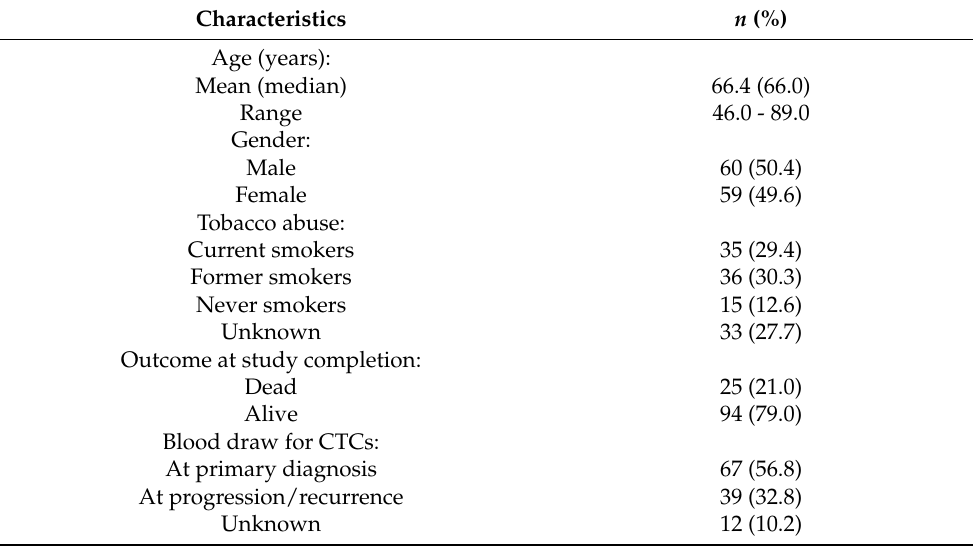
Table 1. Characteristics of the 118 NSCLC study